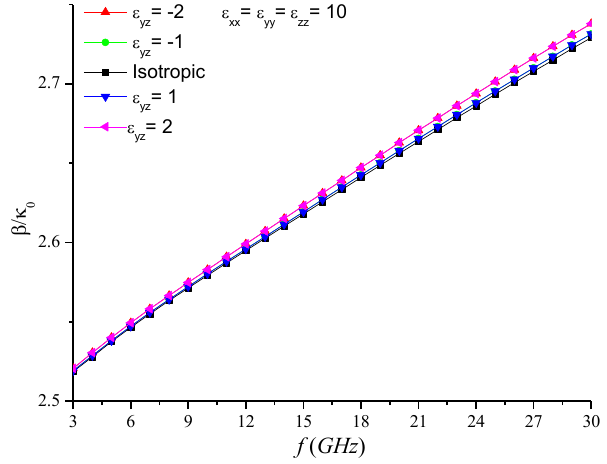
Figure 7.a: Effect of real valued e yz on the normalized phase constant